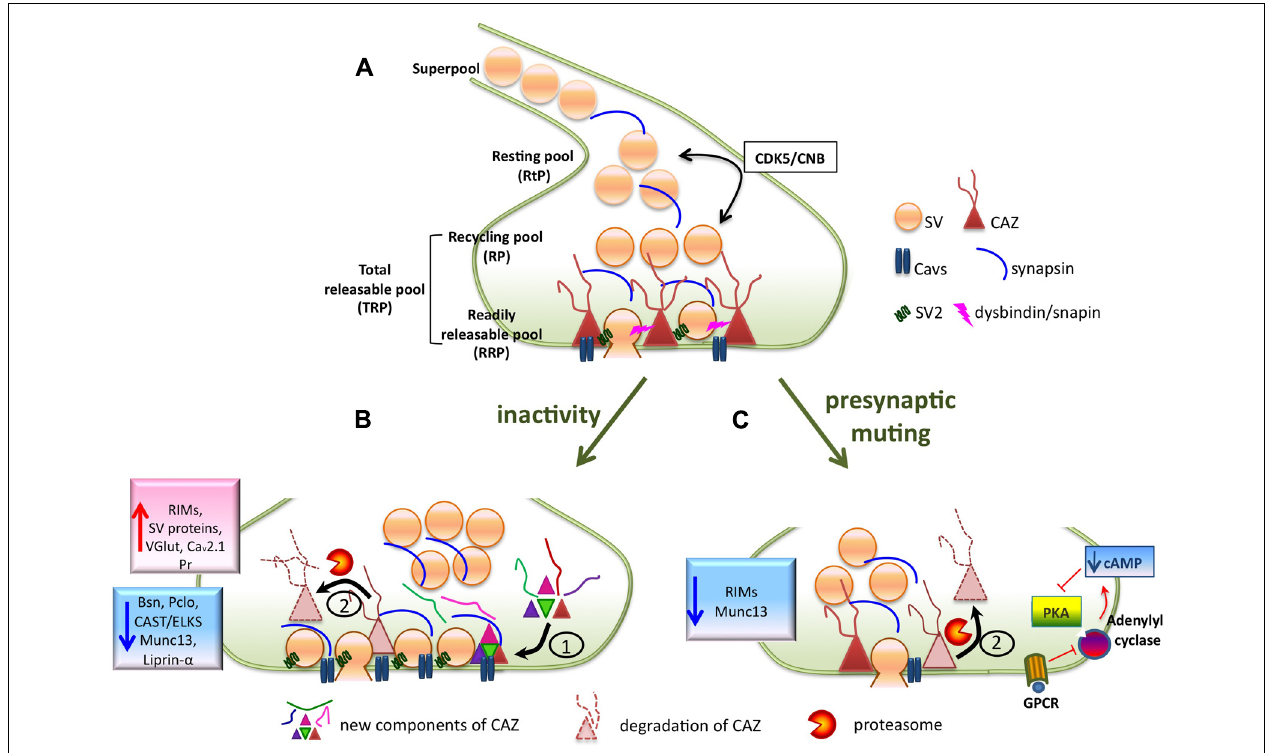
FIGURE 1 | (A) Scheme of a presynaptic bouton containing synaptic vesicles that can be assigned to functionally different pools (RRP, RP, RtP), the release machinery (depicted as cytomatrix at the active zone, CAZ) and the presynaptic Ca 2 + channels Cavs. (B) Prolonged activity deprivation induces extensive structural (enlargement of active zones) and functional (increased RRP and Pr) remodeling of presynaptic active zones, which is associated with a molecular reorganization of the release machinery.